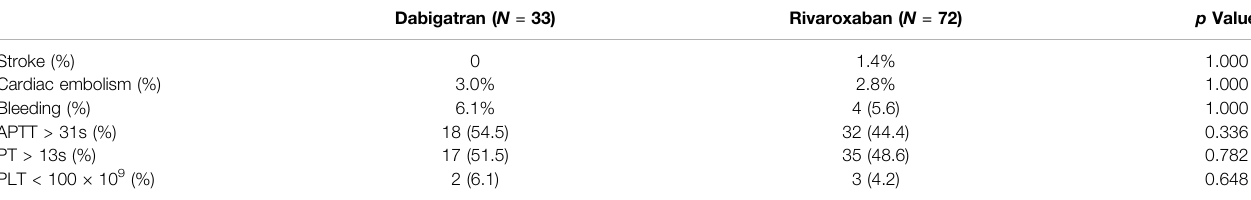
TABLE 5 | Clinical outcome assessments of the study